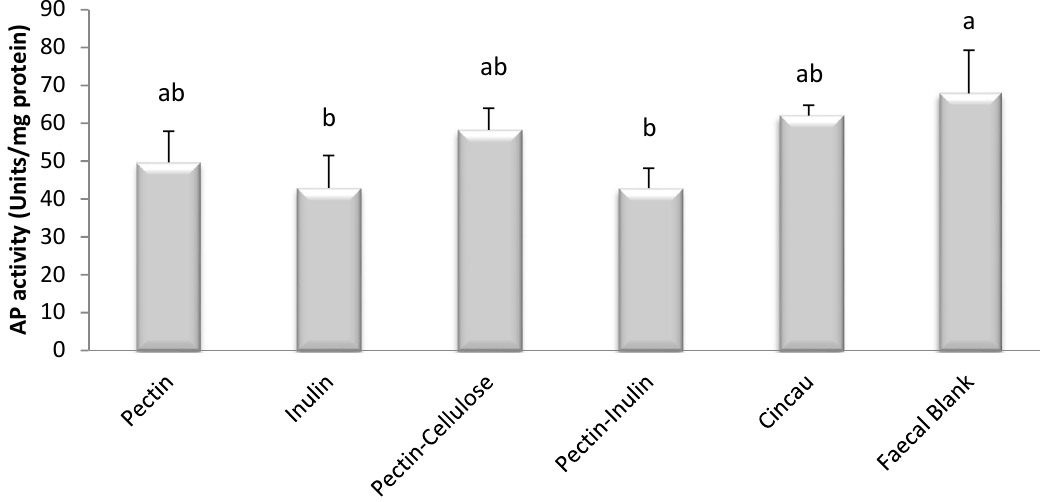
Figure 3. Effect of dietary fibre FS on alkaline phosphatase (AP) enzyme levels. AP enzyme activity was measured by hydrolysis of p -nitro phenol phosphate (5 mM) and expressed in units (the number of µmol p -nitrophenol liberated in 1 min measured at 400 nm per mg protein). The bars represent the mean, and the lines are SEM of three independent experiments each performed in triplicates. Data points denoted by different superscripts (letters above the bar) differ significantly with p < 0.05.